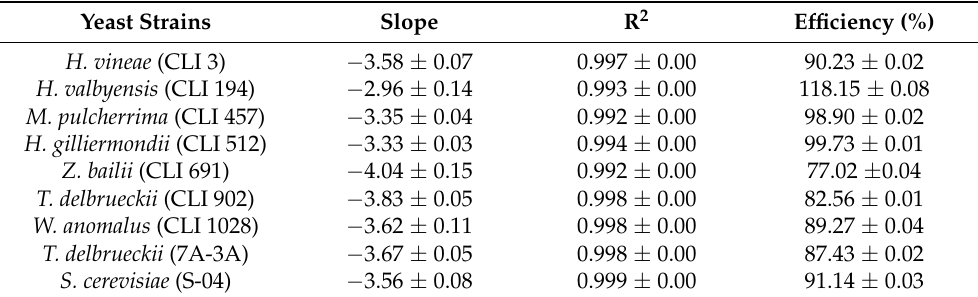
Table 5. Correlation coefficient, slope, and efficacy of the standard curves in YPD for the differ- ent